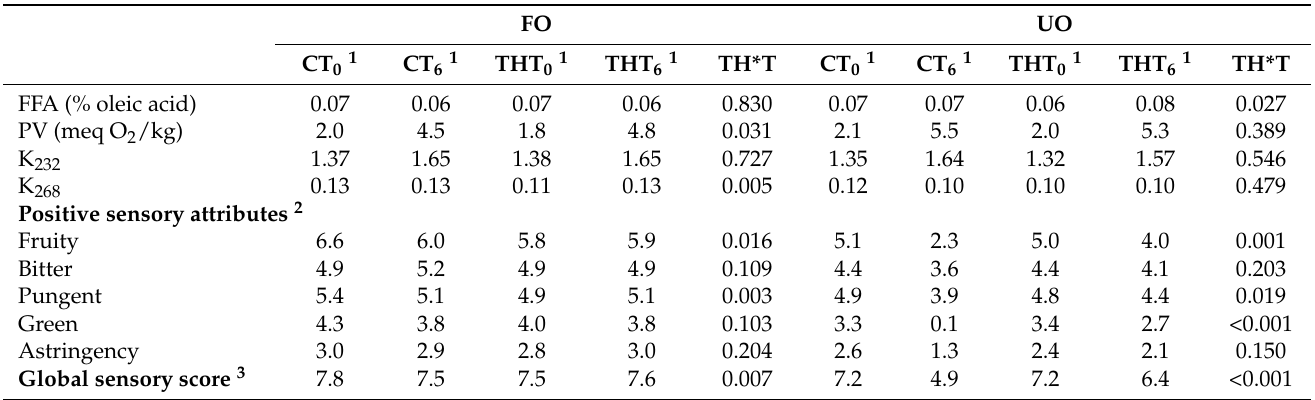
Table 2. Changes in physicochemical and sensory quality parameters (mean values) assessed in fresh (control) and thawed filtered (FO) and unfiltered (UO) oils after 6 months of storage at room temperature and the effect of the interaction ( p values) between thawing and storage time (TH*T) assessed by two-way